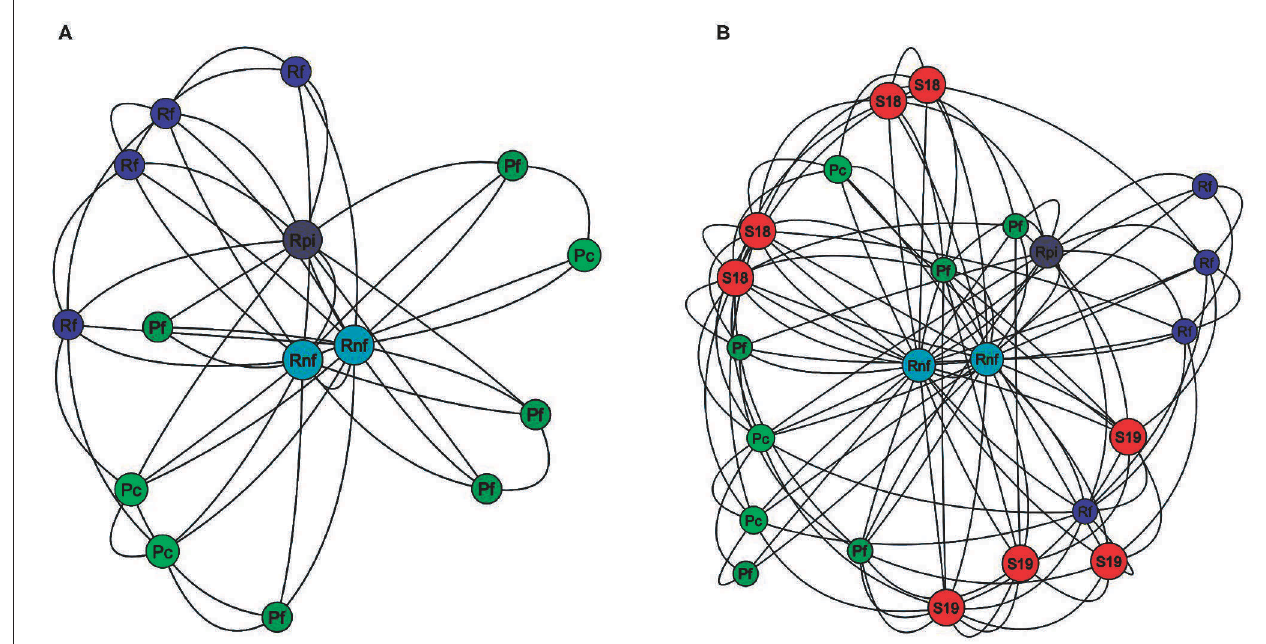
FIGURE 5 | Network analysis. All participants were asked the people with whom they interacted with most during the current project. (A) Researchers and partners only. Non-faculty researchers (light blue, R nf ) Kat and Jennifer represent central nodes in the network with connections to all program participants. Faculty researchers (dark blue, R f ) have formed a cluster, with Nic, the principal investigator (dark blue, R pi ) connecting them to partners. Partner farmers (dark green, P f ) and coordinators (light green, P c ) cluster close to others from their organization but are not connected to other partners. (B) Researchers, partners, and students. Students (orange) are pivotal in creating interconnections between participants in different roles. Students also form clusters based on the year they were employed- − 2018 (S18) or 2019